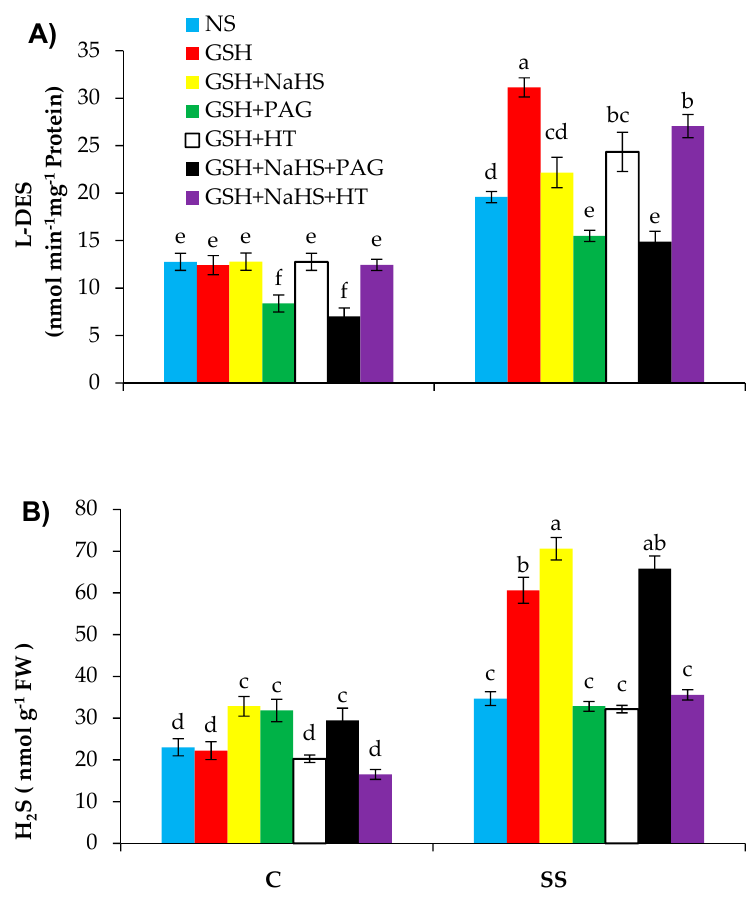
Figure 5. l -cysteine desulfhydrase ( l -DES; ( A )) and hydrogen sulfide (H 2 S ( B )) in pepper plants grown under control (C) and salinity stress (SS 100 mmol L − 1 NaCl), sprayed with glutathione (1.0 mmol L − 1 GSH) or sodium hydrosulfide (0.2 mmol L − 1 NaHS) alone or together, combined with a 0.1 mmol L − 1 scavenger of H 2 S, hypotaurine (0.1 mmol L − 1 HT), or inhibitor of l -DES, dl -propargylglycine (0.3 mmol L − 1 PAG). (Mean ± SE). Mean values carrying di ff erent letters within each parameter di ff er significantly ( p ≤ 0.001) based on Duncan’s multiple range